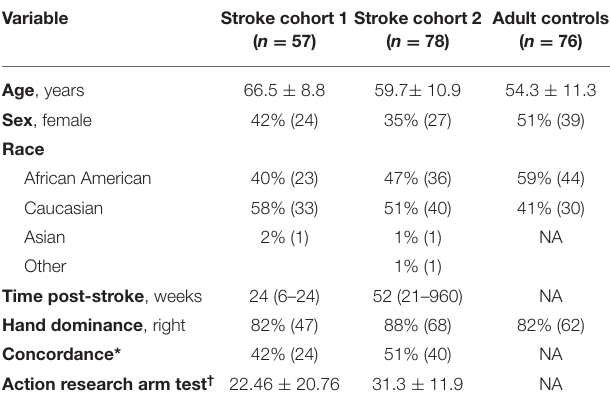
TABLE 2 | Demographics and participant characteristics of the three cohorts.